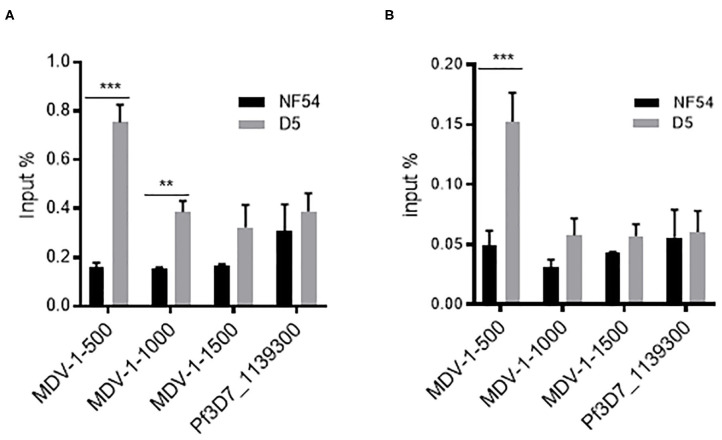
ChIP-qPCR analysis of PfAP2-G2 binding to the promoter region of PfMDV-1 at ring stage (A) and schizont stage (B). MDV1-500, MDV1-1000, and MDV1-1500 indicate primers that are located at about 500 bp, 1,000 bp, 1,500 bp before the start codon of PfMDV-1, respectively. TSS of PfMDV-1 is mapped to about 500 bp upstream of the start codon. Pf3D7_1139300 was used as a negative control. Primers for ChIP-qPCR are shown in Supplementary Table 1. The experiment was repeated three times. All error bars indicate SD. **P < 0.01; ***P < 0.001.